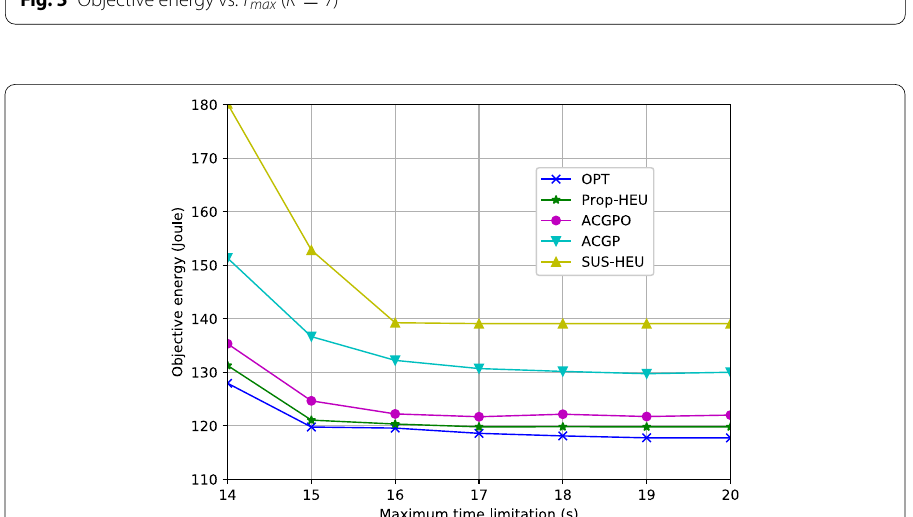
Fig. 6 Computational time vs. K ( T max = 16 s